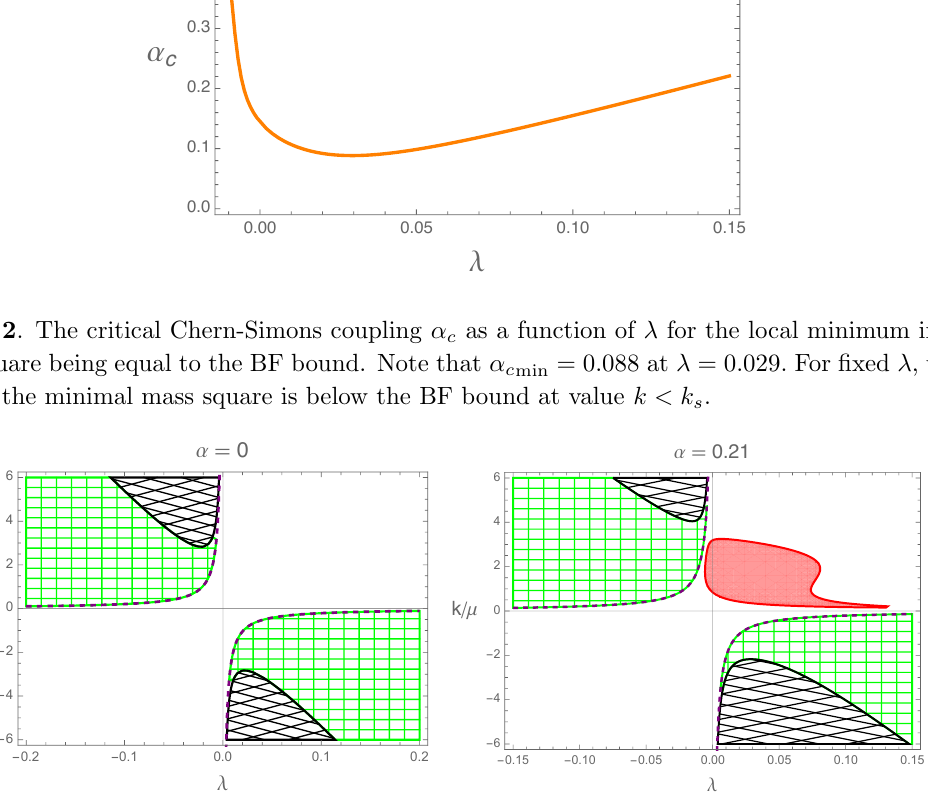
Figure 3 . The behaviour of m 2 as a function of k=(cid:22); (cid:21) , at (cid:11) = 0 (left) and (cid:11) = 0 : 21 (right). 1 (cid:0) In both plots, m 2 is complex inside the black meshed region, below the BF bound in the green 1 (cid:0) meshed region and above the BF bound in the rest of the white space. The dashed purple line corresponds with k = (cid:0) k s in (3.10) and the green region are the instabilities inherited from the scale k s . In the right plot m 2 is also below the BF bound inside the red region (related to scale 1 (cid:0) k v ) and this is related to gauge Chern-Simons term (cid:11) . The sector of m 2 can be obtained by the 1+ transformation k ! (cid:0) k . Since for real mass squares we have m 2 (cid:20) m 2 , it is su(cid:14)cient to study 1 (cid:6) 2 (cid:6) m 2 for the instability 1